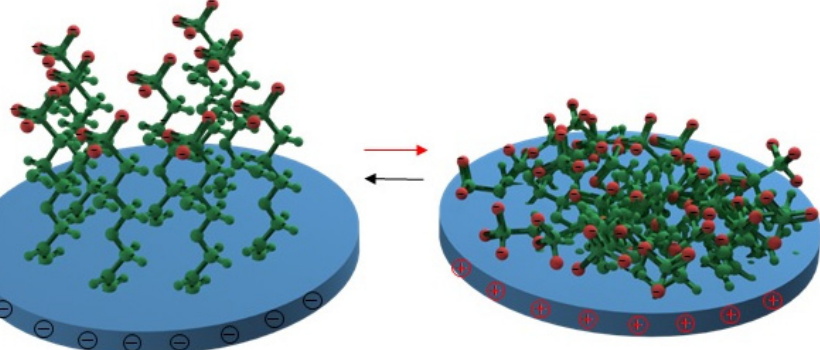
Figure 14. A schematic molecular model of the stretched and rolled electro-controllable poly-sodium allyloxy hydroxypropyl sulfonate-branched brushes after being negatively and positively charged [123].